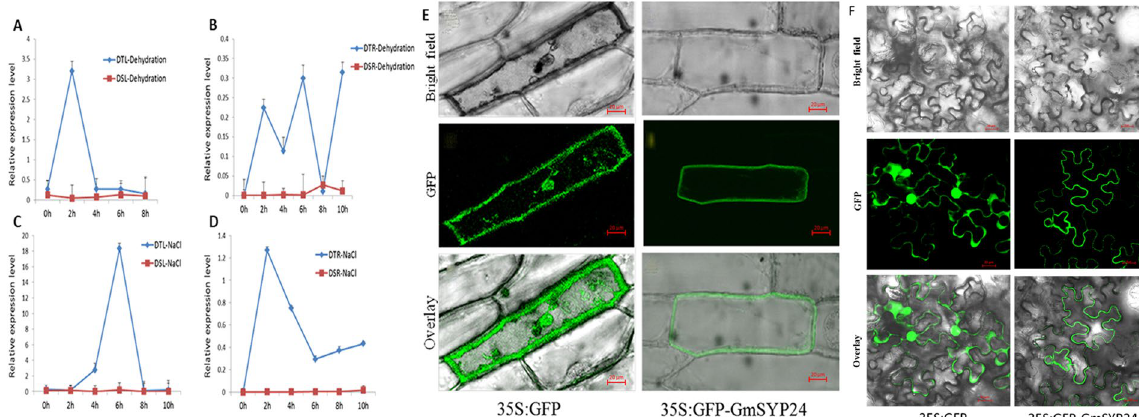
Figure 4. The expression pattern of GmSYP24 and sub-cellular location. Bars indicate SE of the mean. ( A – D ), The expression of GmSYP24 in the leaf or root of drought-tolerant and -sensitive under dehydration or salt. ( E ) The sub-cellular location of GmSYP24 protein in onion epidermal cells. ( F ) The sub-cellular location of GmSYP24 protein in tobacco epidermal cells. Scale bars = 20 μ